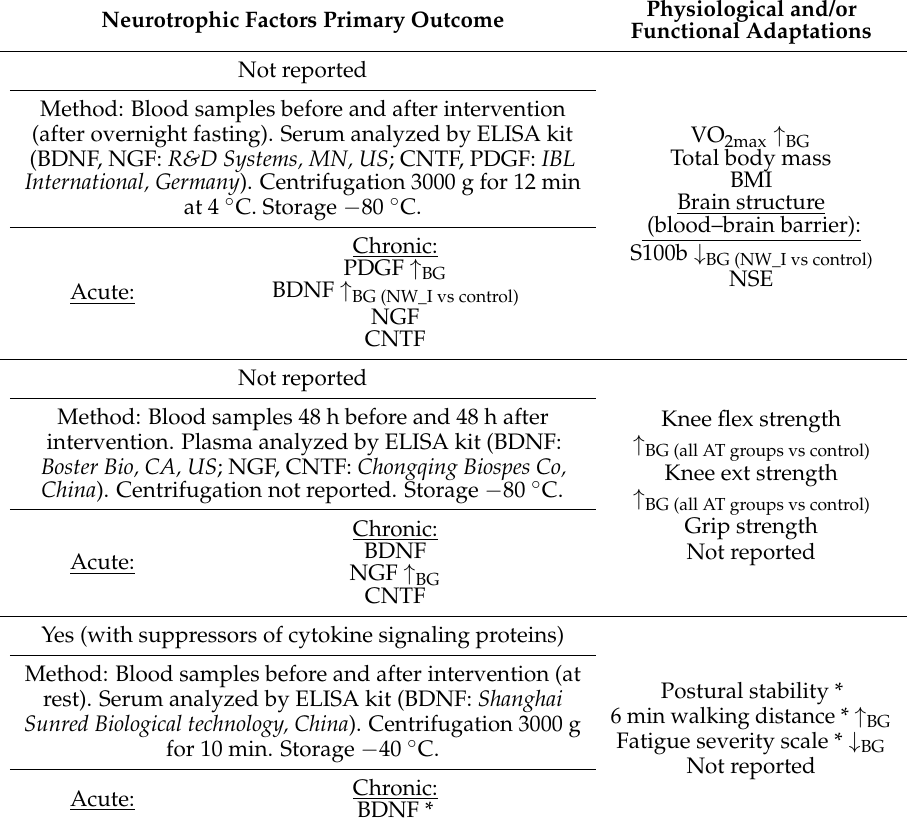
Physiological and/or Functional